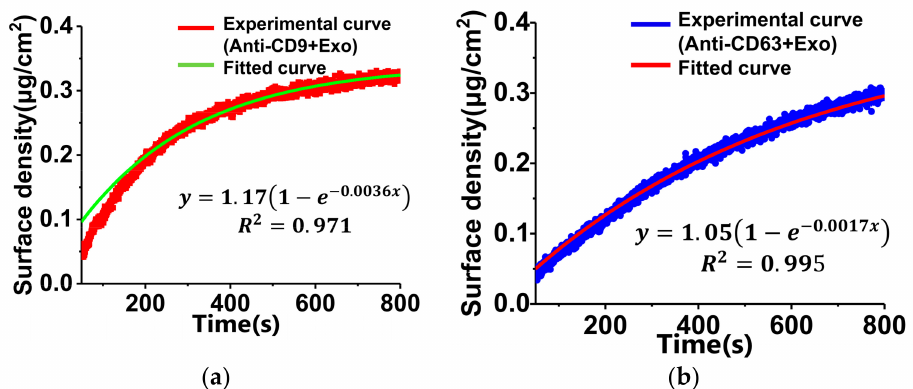
Figure 5. The experimental and fitted curve for the interaction between antibodies and exosomes. ( a ) The red curve represents the interaction between exosomes and anti-CD9; ( b ) the blue curve represents the interaction between exosomes and anti-CD63.